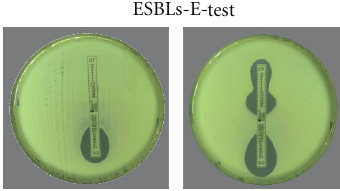
Figure 3: MICs that are > 8 fold lower with clavulanate (left) or the presence of keyhole zones (right) imply ESBL